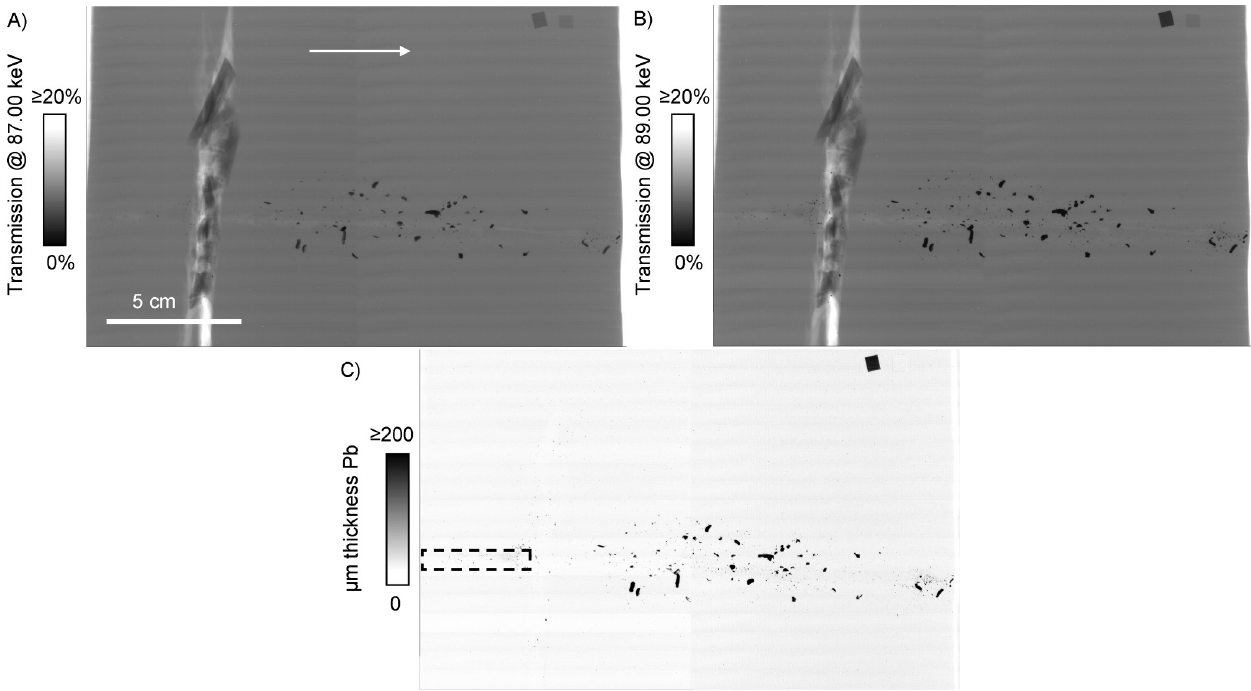
Fig 4. Lead K edge subtraction imaging of the lead-core bullet with bone sample. The bullet trajectory is indicated by the arrow, and all images are on the same spatial scale. (A) Transmission image at 87.00 keV. (B) Transmission image at 89.00 keV. (A) and (B) are on the same contrast scale. (C) K edge subtraction image, with contrast scale of micrometer thickness of lead. All non-lead structures including bone and copper are subtracted out in the process. The dashed box in (C) outlines an area that was selected for high resolution imaging.